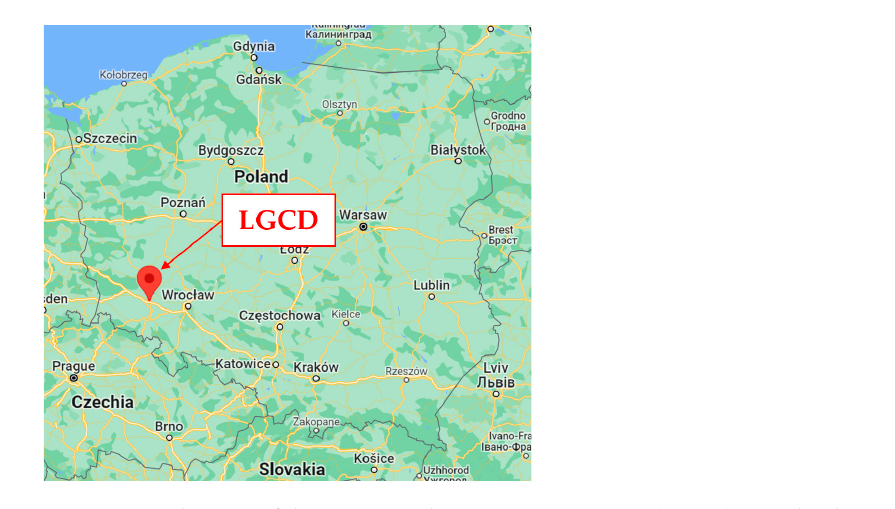
Figure 6. Localization of the Legnica–Głogow Copper District (LGCD) on Polands’ map. The time histories of accelerations in three directions and the Fourier spectra of the